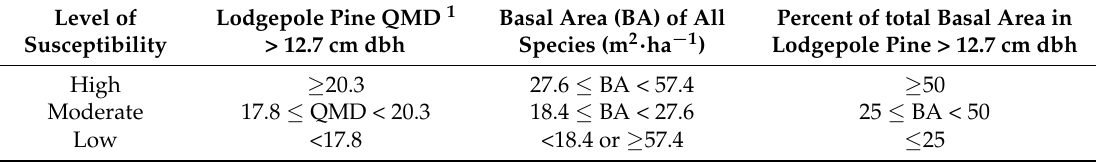
Table 3. Important elements of stand composition and structure associated with susceptibility to mountain pine beetle attack in lodgepole pine forests (after [23]). In general, susceptibility increases with increasing size, density, and percentage of lodgepole pine.